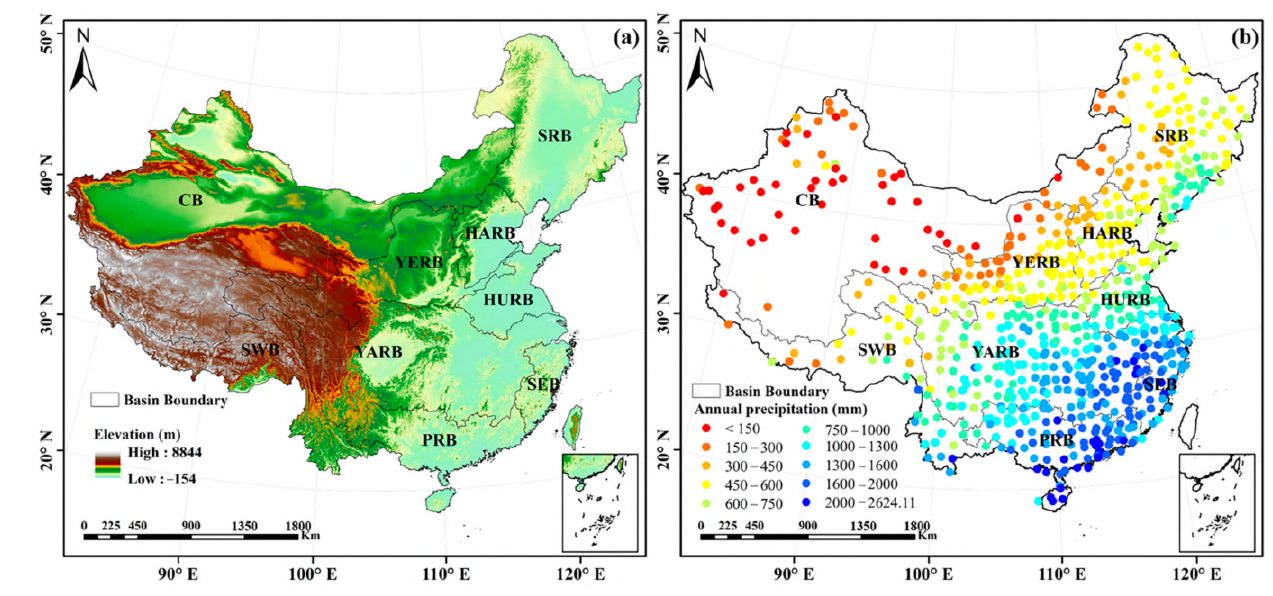
Figure 1. ( a ) Topography map of the China and different basins; and ( b ) the spatial distribution of 696 daily rain gauges, the division of nine basins and the annual mean precipitation during 2008–2017. CB, Continental Basin; HARB, Haihe River Basin; HURB, Huaihe River Basin; PRB, Pearl River Basin; SEB, Southeast Basin; SRB, Songliao River Basin; SWB, Southwest Basin; YARB, Yangtze River Basin; YERB, Yellow River Basin. Each point represents a rain gauge in ( b